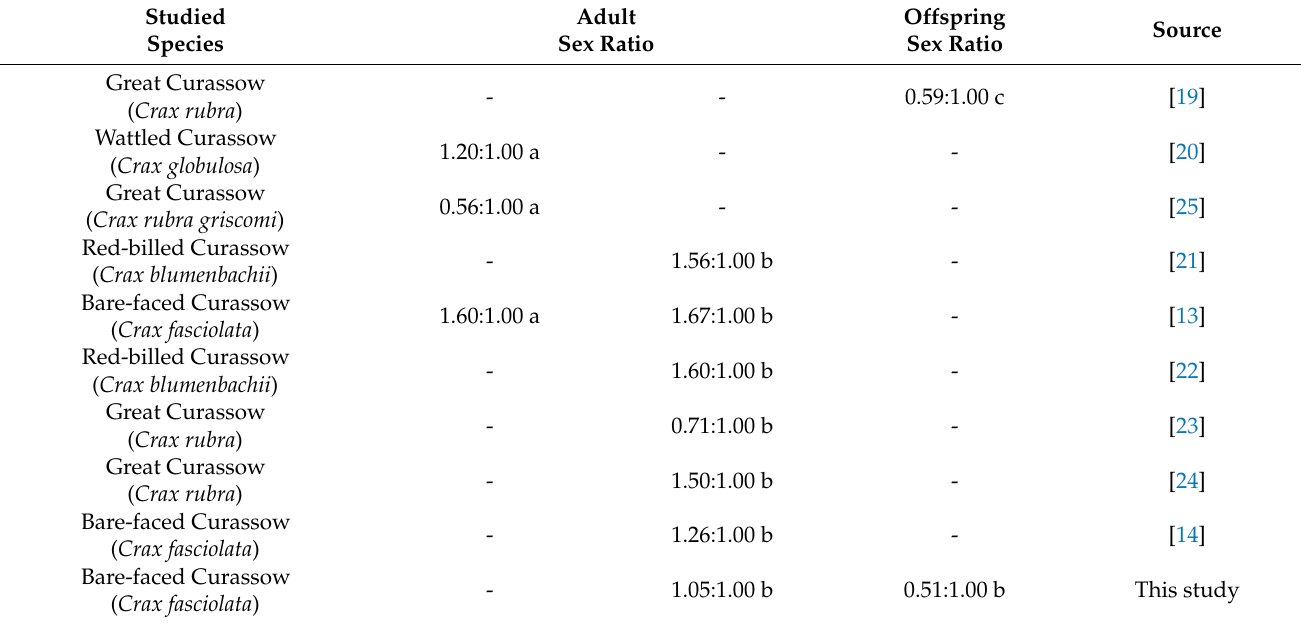
Table 4. Sex ratio data available for various Crax species relative to pooled and adjusted data available from various surveys. In each case, the sex ratio is expressed as the number of males per female. Approaches considered: a—visual survey; transect-based survey; b—camera-trap-based survey; c—observed in